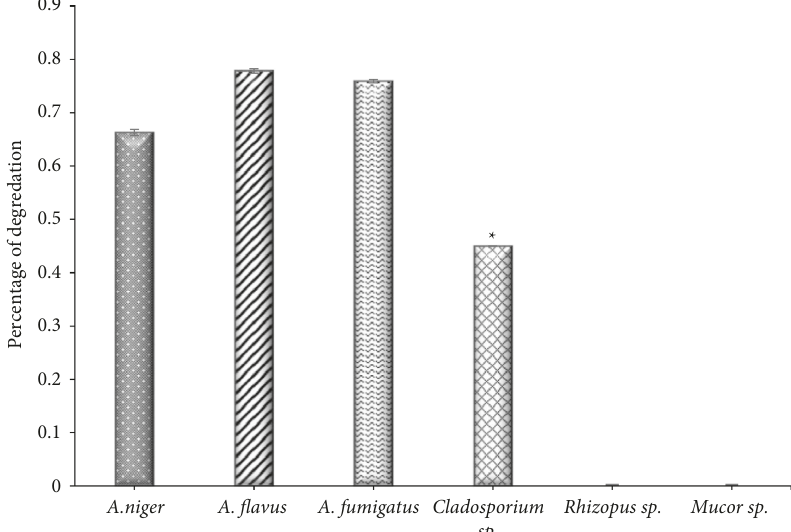
Figure 3: The activity of protease of endophytic fungi isolated from Ziziphus spina leaves on solid medium. ∗ Significant difference with all other groups at P < 0 .